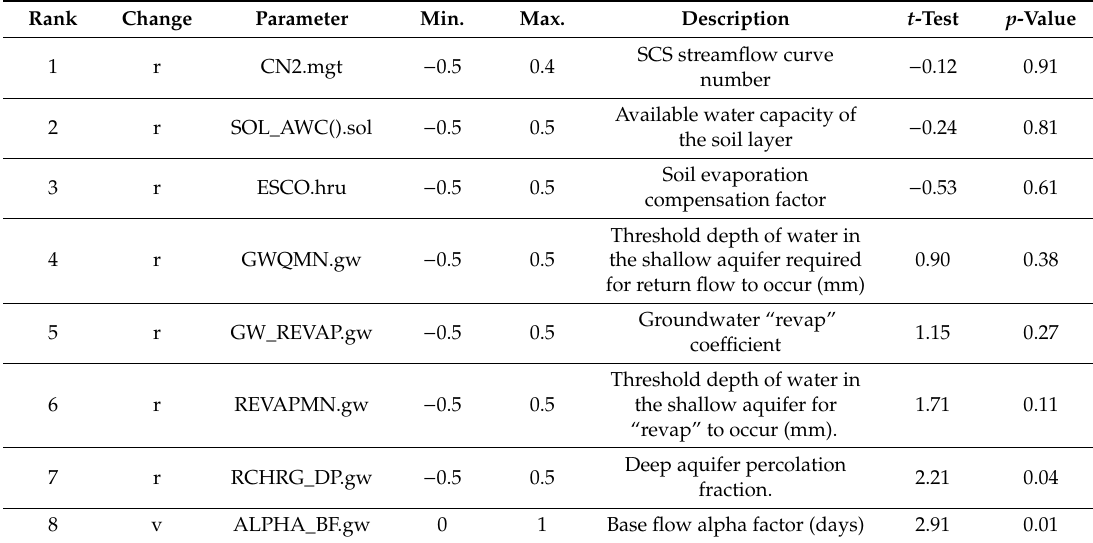
Table 3. Calibrated hydrologic parameters for the Hemrin